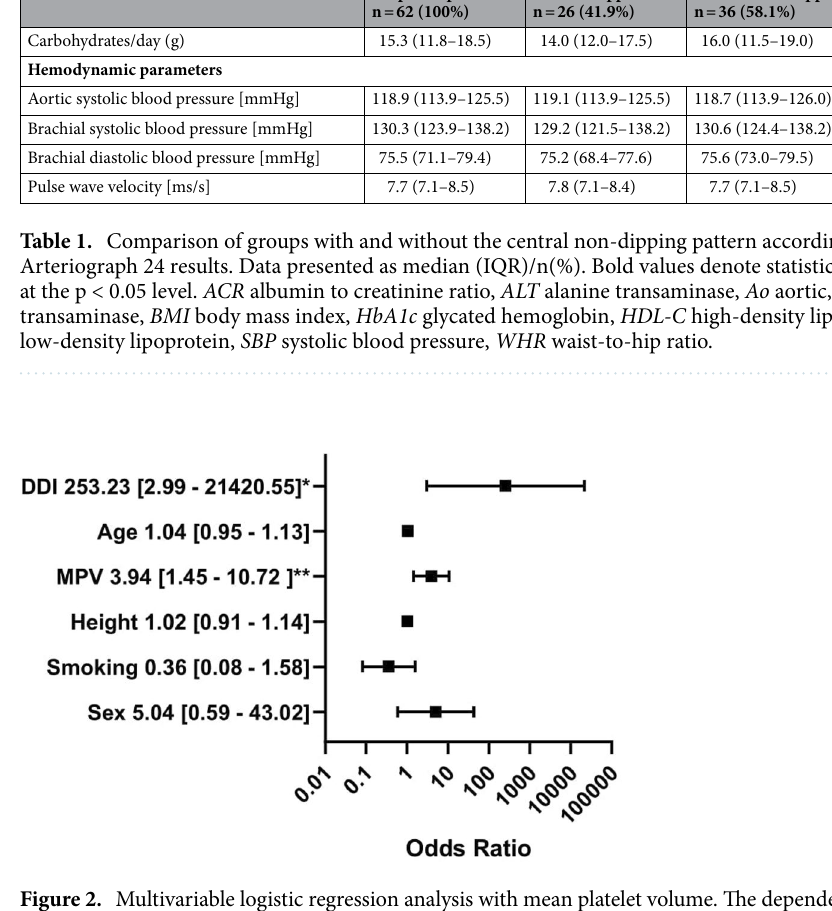
Figure 2. Multivariable logistic regression analysis with mean platelet volume. The dependent variable: the presence of central non-dipping pattern (coded one). The outcomes presented as a dependent variable (odds ratio, 95% confidence interval). *Significant at the 0.05 level; **significant at the 0.01 level. MPV mean platelet volume, DDI daily insulin intake. All figures made by authors of the manuscript. GraphPad Prism 9 (https:// www. graph pad. com/) was used to create forest plots.